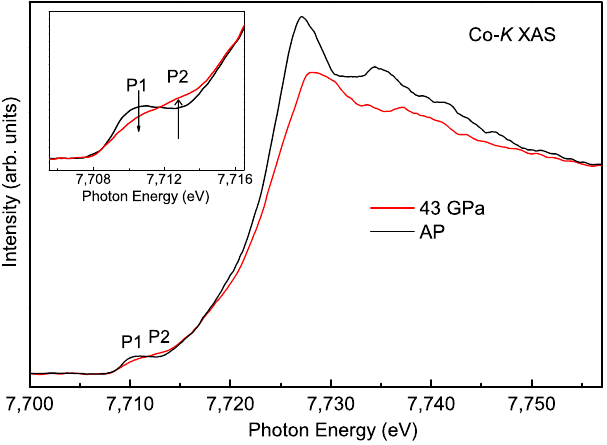
Figure 2. The Co- K PFY XAS spectra of Sr 2 Co 0.5 Ir 0.5 O 4 at ambient pressure and 43 GPa.